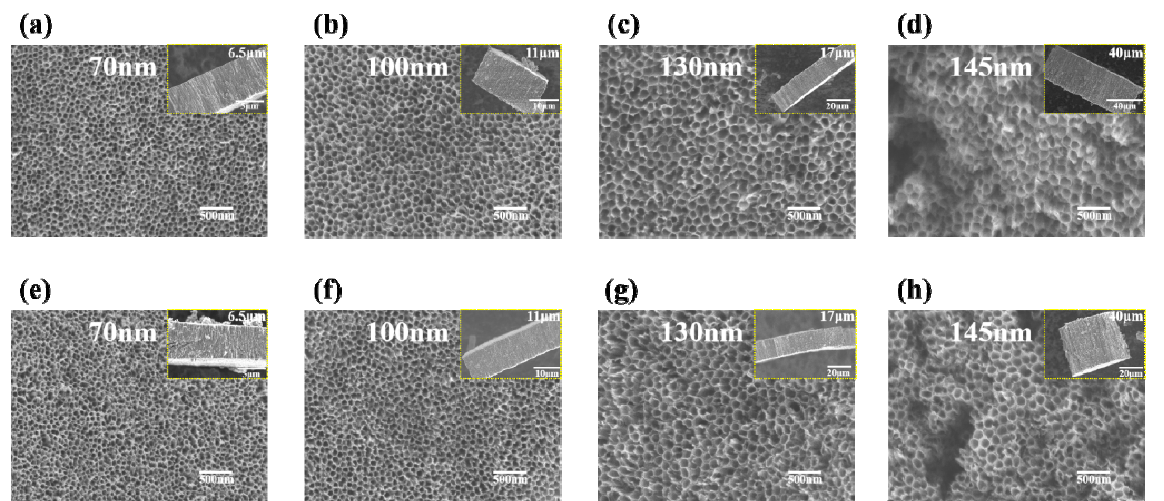
Figure 5. SEM images of top view of TiO 2 nanotube arrays before ( a – d ) and after ( e – h ) annealing with different oxidation times in electrolyte with 0.2 wt% NH 4 F: ( a , e ) 2 h; ( b , f ) 5 h; ( c , g ) 10 h; ( d , h ) 20 h. Inserts show side view of TiO 2 nanotube arrays.